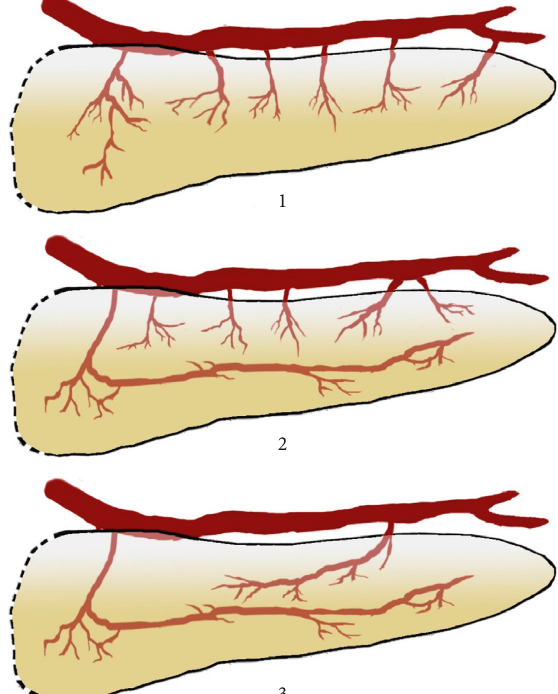
Figure 1: Schematic representation of the arterial supply of the pancreas based on the arteries that are involved in its arterial supply. Vascularization: 1: by the short branches of the splenic artery (type 1); 2: by the long and short branches of the splenic artery (type 2); 3: only by the long branches of the splenic artery (type